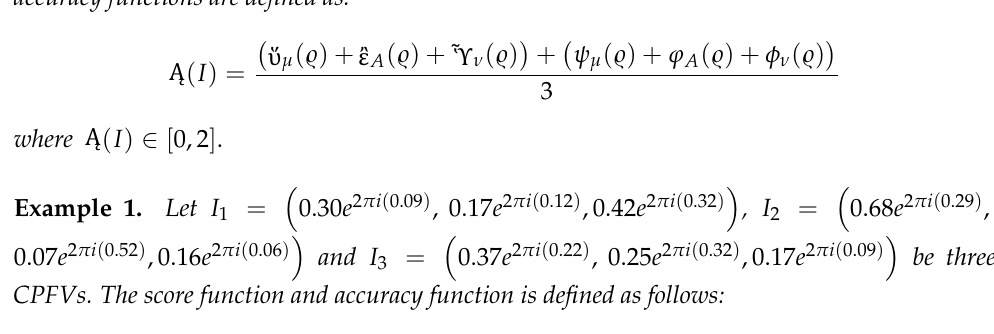
Table 1. Symbols and their meanings. Symbols Meanings Symbols Meanings